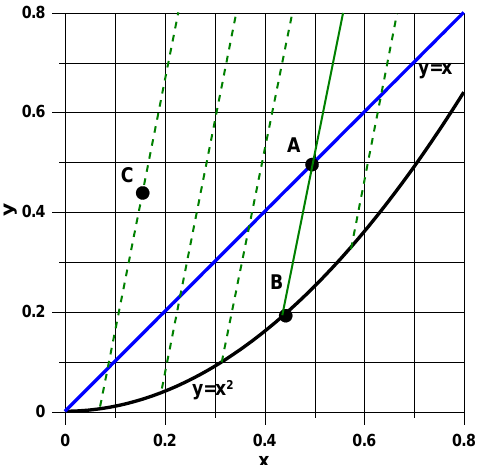
Figure A1. Construction of the required eigenfrequencies and stacking sequences.